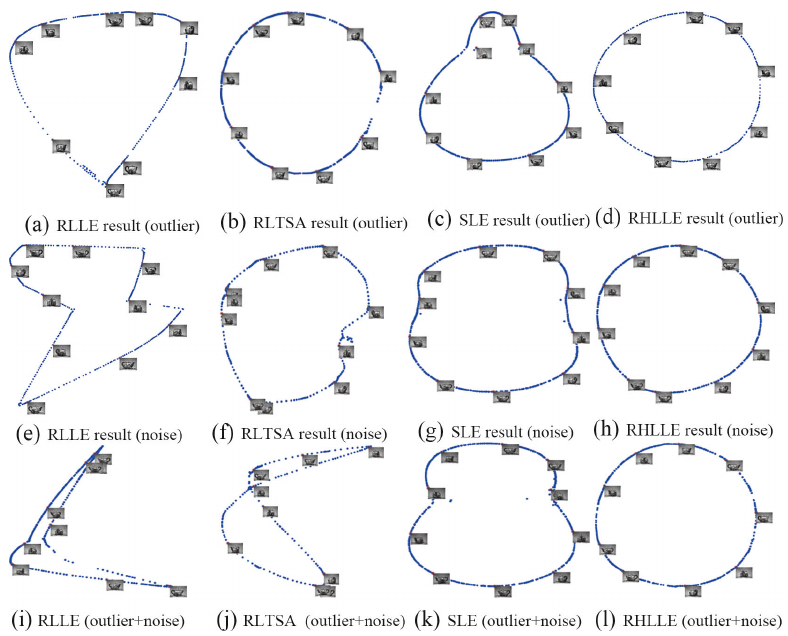
Figure 7. 2D embedding results of RLLE, RLTSA, SLE and RHLLE on the teapot image set with outliers, noise and both outliers and noise respectively.